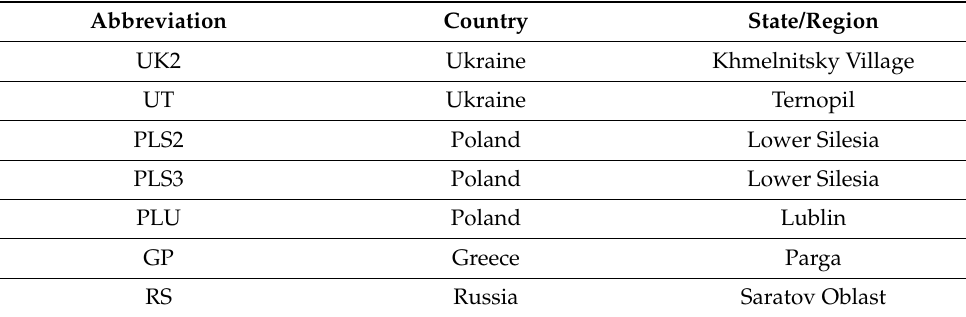
Table 2. Origin and abbreviations of analysed propolis